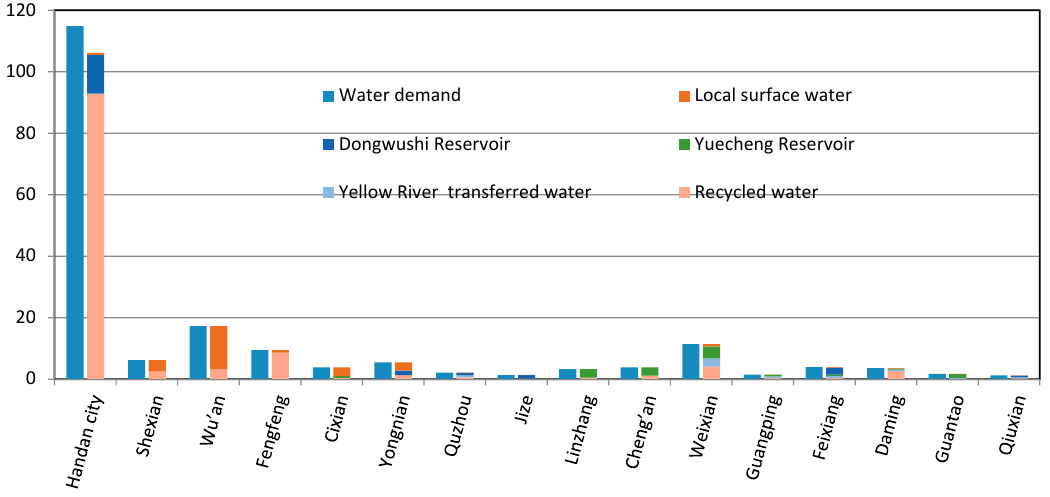
Figure 9. Ecological water allocation in each sub-region in Handan (10 6 m 3 ).